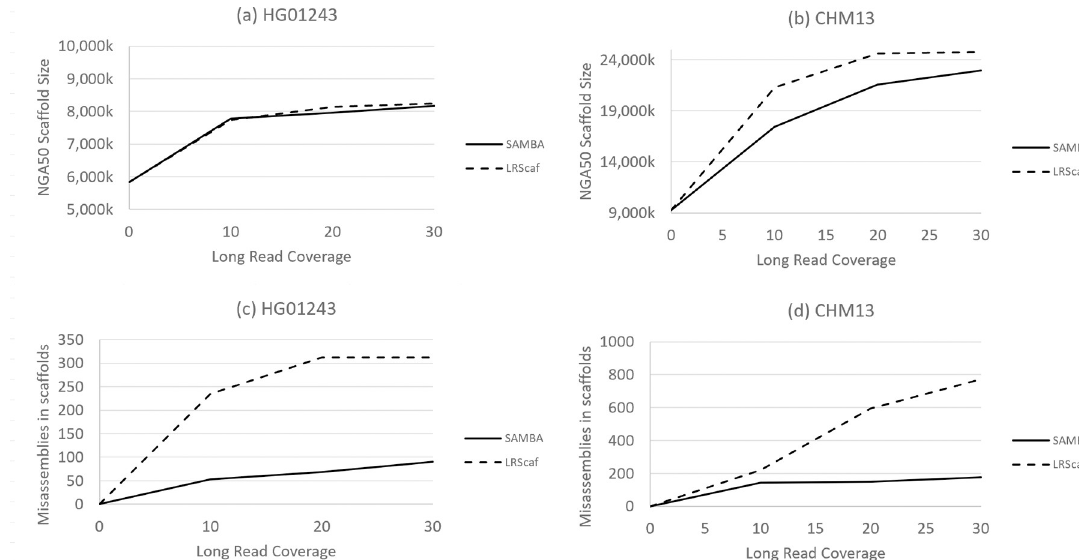
Fig 2. Contiguity and accuracy results for SAMBA and LRScaf on scaffolding of human assemblies CHM13 (CHM13-WashU) and HG01243 (HG01243-IP) using varied coverage of Oxford Nanopore Technologies (ONT) ultralong reads. The x-axis shows coverage in the ONT reads. All assemblies were evaluated by Quast using the CHM13 v1.1 assembly as the reference for CHM13, and the PR1 assembly (Zimin et al., 2021) for HG01243. Panels (a) and (b) compare NG50 sizes for the two different human assemblies, while (c) and (d) compare the number of mis-assemblies. Both scaffolders produced similar NG50 sizes for HG01243, while LRScaf produced bigger scaffolds for CHM13 data. SAMBA had fewer mis-assemblies in both genomes at all depths of coverage.